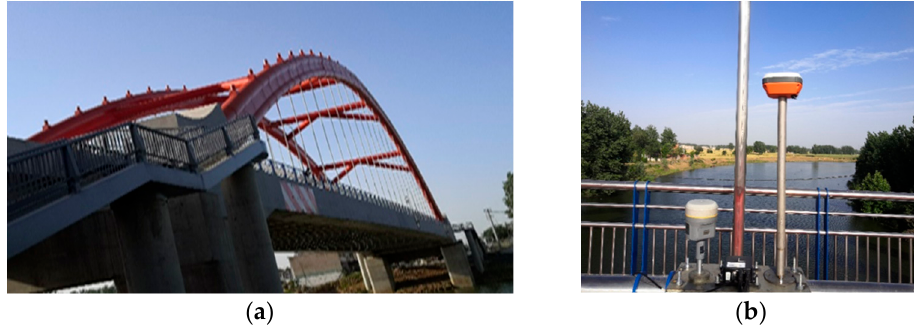
Figure 2. Monitoring site and device: ( a ) Suntuan River Bridge; ( b ) monitoring station.